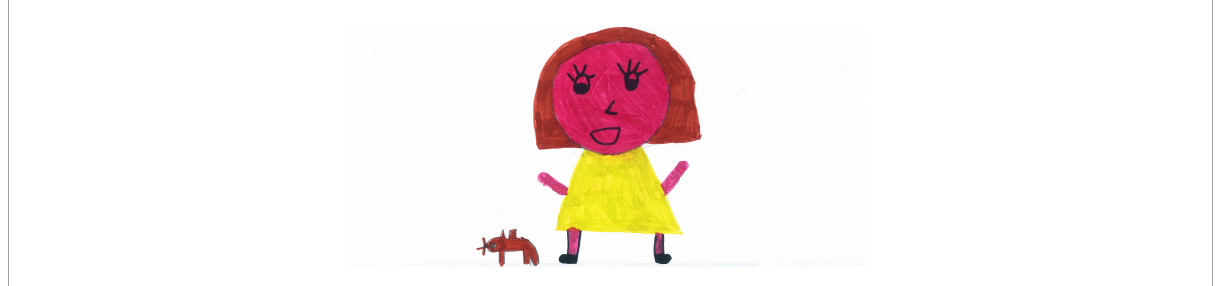
FIGURE9 A young girl is playing with a pet (PS, female, 7 Years).